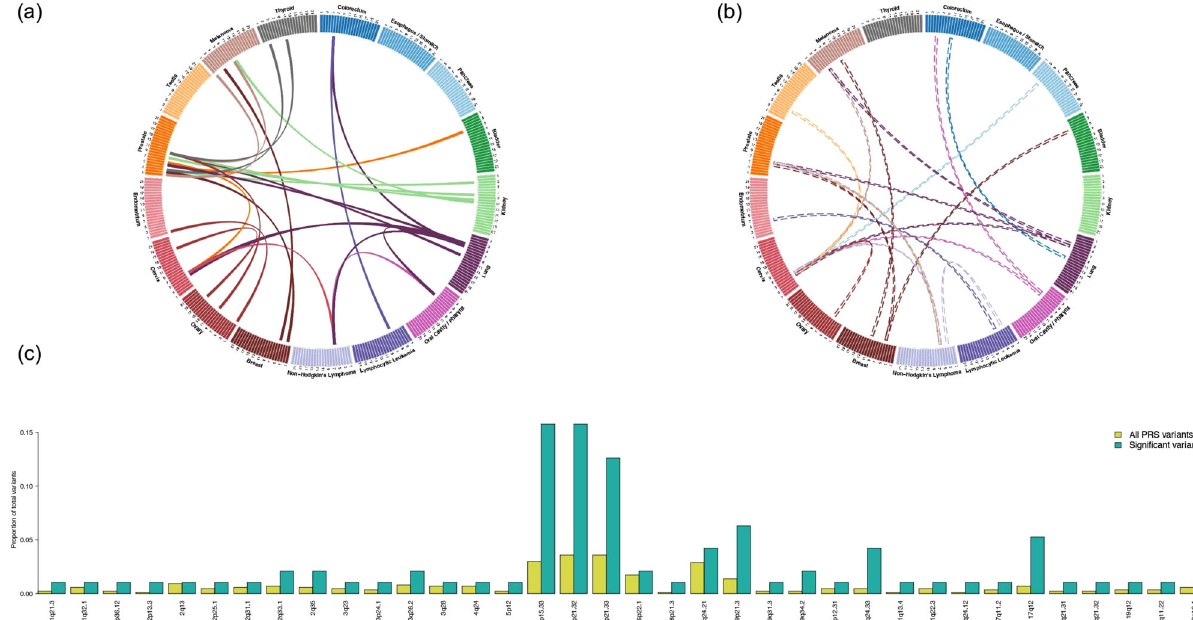
Fig. 2 Pleiotropic risk variants from the 16 cancer-speci fi c polygenic risk scores (PRS). a Circos plot describing each previously unreported positive association between a known risk variant for one cancer type and another cancer phenotype. b Circos plot describing each previously unreported inverse association between a known risk variant for one cancer type and another cancer phenotype. Each line in a and b represents a signi fi cant association between a risk variant for the cancer from which the line originates (denoted by line color) and the cancer type to which the line connects. Odds ratios were estimated from logistic regression models, p values were calculated from two-sided Wald tests, and statistical signi fi cance ( p < 0.05/798 = 6.3 × 10 − 5 ) was determined correcting for the number of effective independent tests. Cancers are organized by organ site. c Region enrichment for 141 signi fi cant previously unreported and known associations compared to all PRS variants.